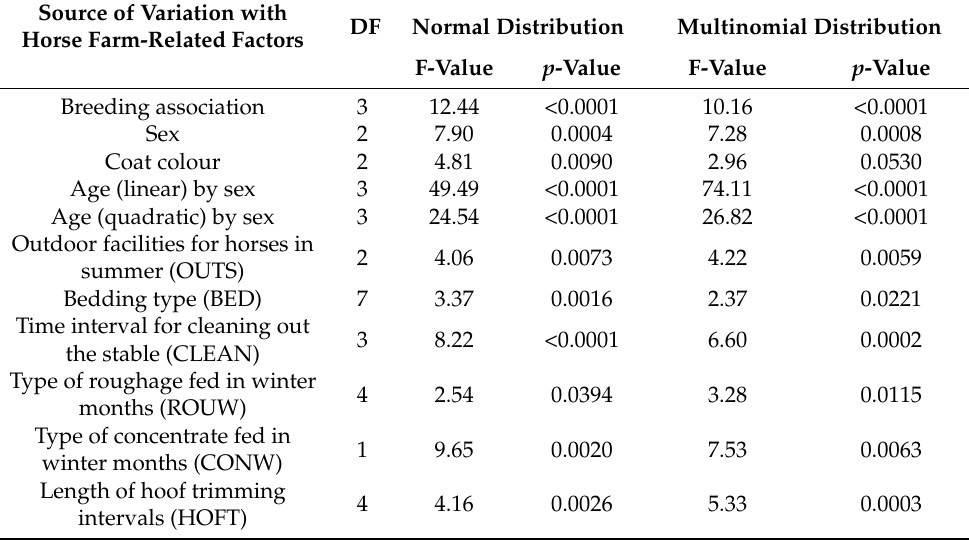
Table 7. Results of the final generalized linear mixed model 2 including horse farm-related factors in addition to model 1 with degrees of freedom (DF), F-values and p -values for CPL-scores in Rhenish German draught horses.